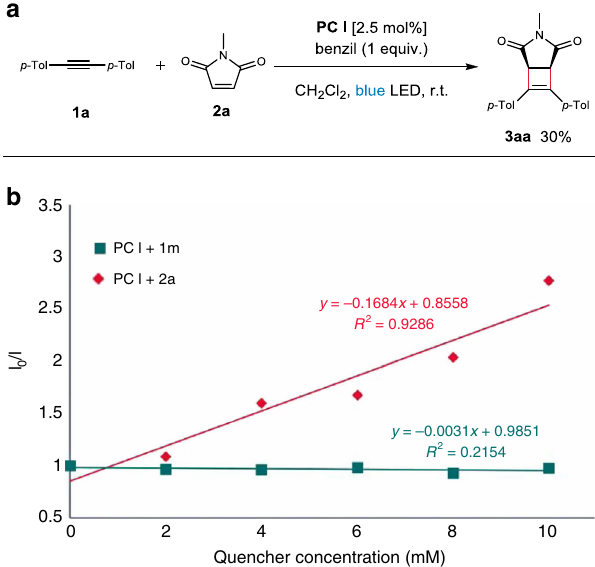
Fig. 5 Mechanistic studies. a Effect of triplet quencher. b Stern – Volmer luminescence quenching experiments using a 0.1 mM solution of PC I and variable concentrations of substrate 1m and 2a in CH 2 Cl 2 .